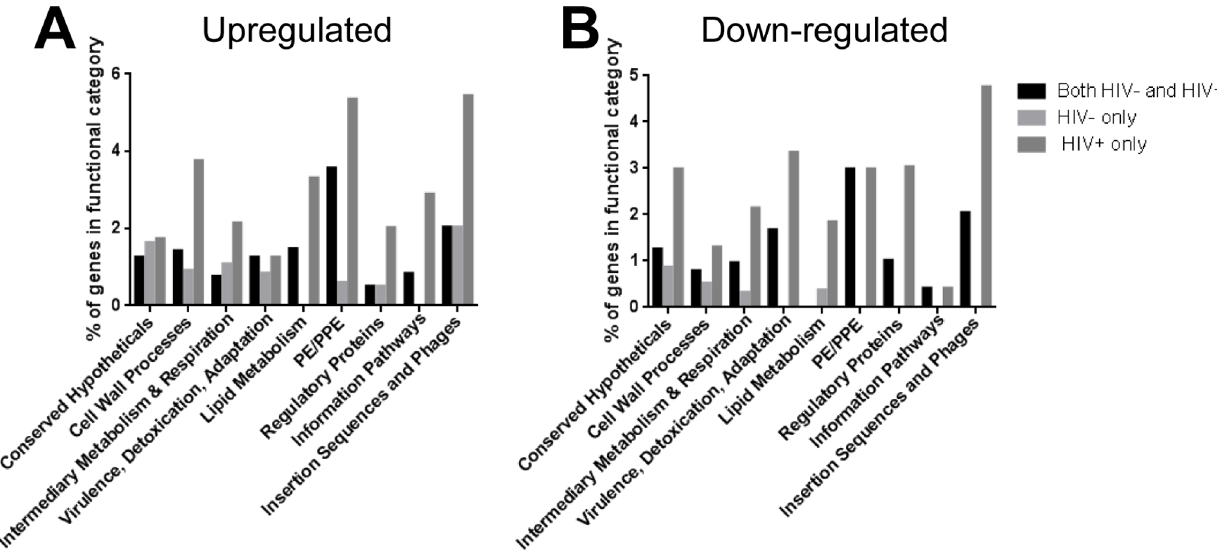
Figure 4. Percentages of genes within functional categories differentially expressed in blood from HIV- and/or HIV + donors. (A) Upregulated genes arranged by functional category and corresponding blood environments. (B) Down-regulated genes arranged by functional category and corresponding blood environments. (Functional categories as designated in the Tuberculist website http://tuberculist.epfl.ch/)